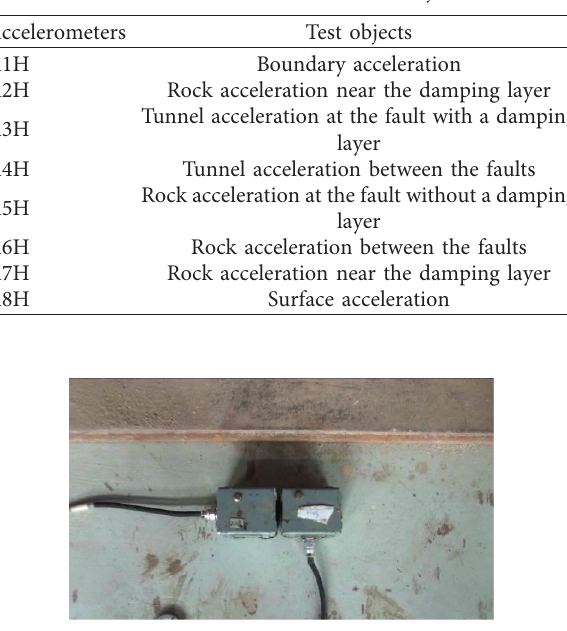
Figure 6: Accelerometers installed on the shaking table.